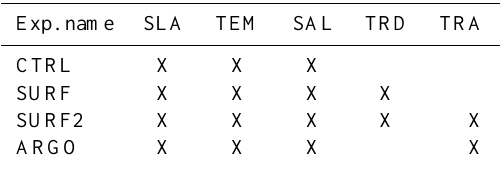
Table 2. 4-month basin-average RMS misfits between model val- ues and observations for sea-level anomalies, sea-surface temper- ature and salinity, as well as surface-drifter and Argo-float posi- tions. “Near-drifter” (as defined in text) SLA RMS misfits are given within the